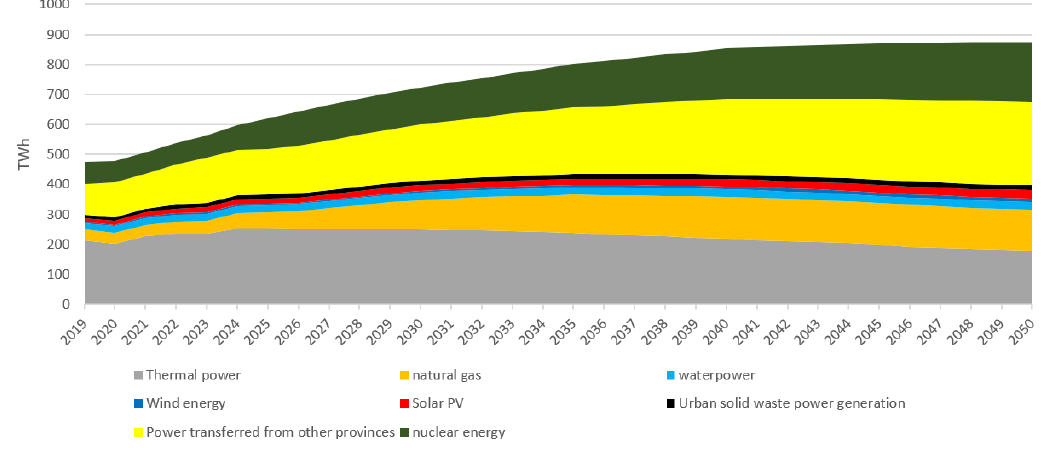
Figure 6. Power generation change in Zhejiang Province under the benchmark scenario.